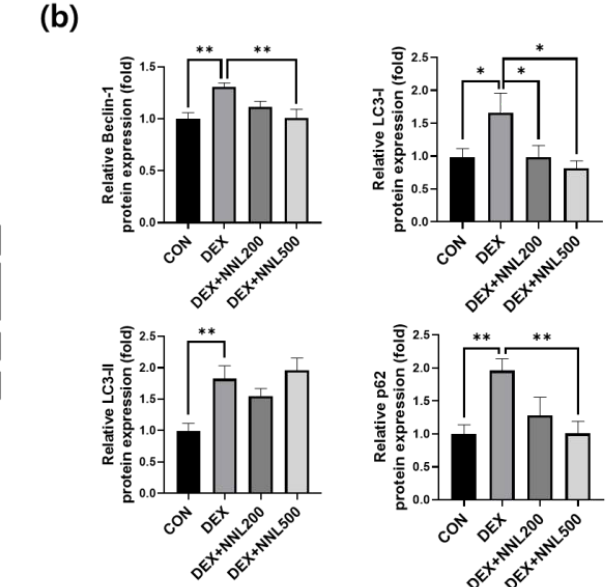
Figure 5. The NNL-extract administration inhibited the expression of autophagy-related factors in DEX-induced muscle atrophy in mice. The protein expression levels of Beclin-1, LC3-I/II, or p62 in the QD muscle tissue were analyzed by immunoblotting. GAPDH was used as an internal control. ( a ) The representative images are shown. ( b ) Beclin-1, LC3-I/II, or p62 immunoblots were quantified in Figure 5a using ImageJ software and normalized to GAPDH. Data are shown as the mean ± S.E.M., n = 6/group; * p < 0.05, ** p < 0.01.